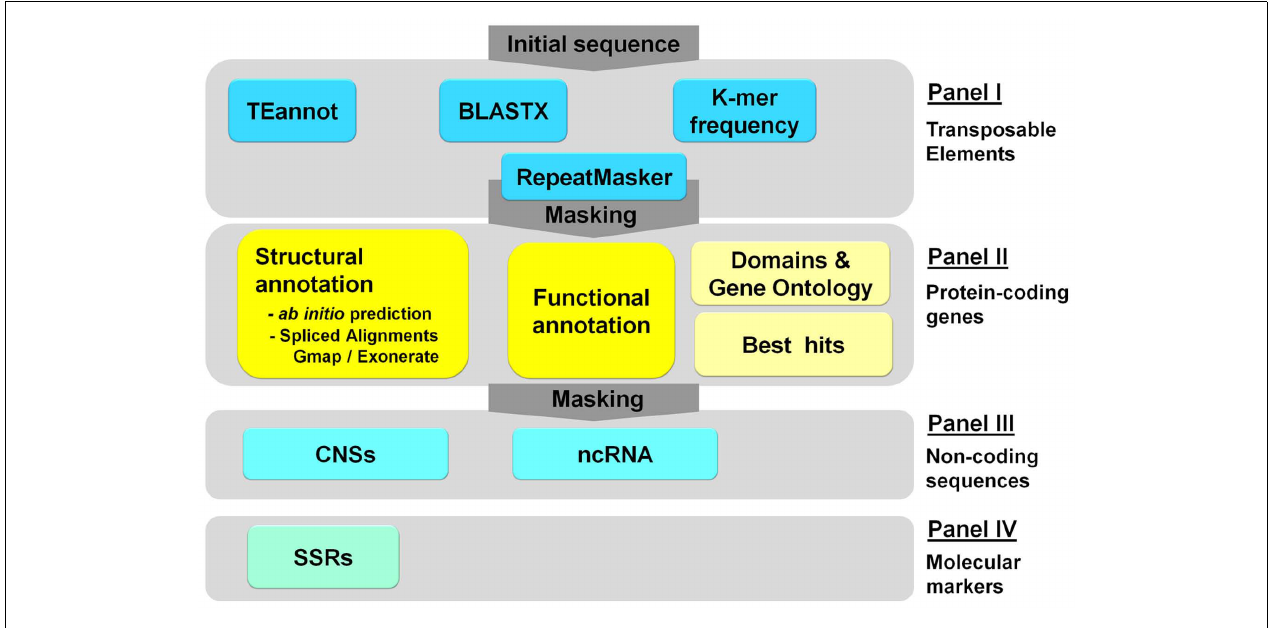
provided in the text. CNSs, conserved non-coding sequences; ncRNA, non-coding RNA; SSRs, simple sequence repeats or microsatellites; TEannot, pipeline for transposable elements annotation (REPET package – Quesneville et al.,